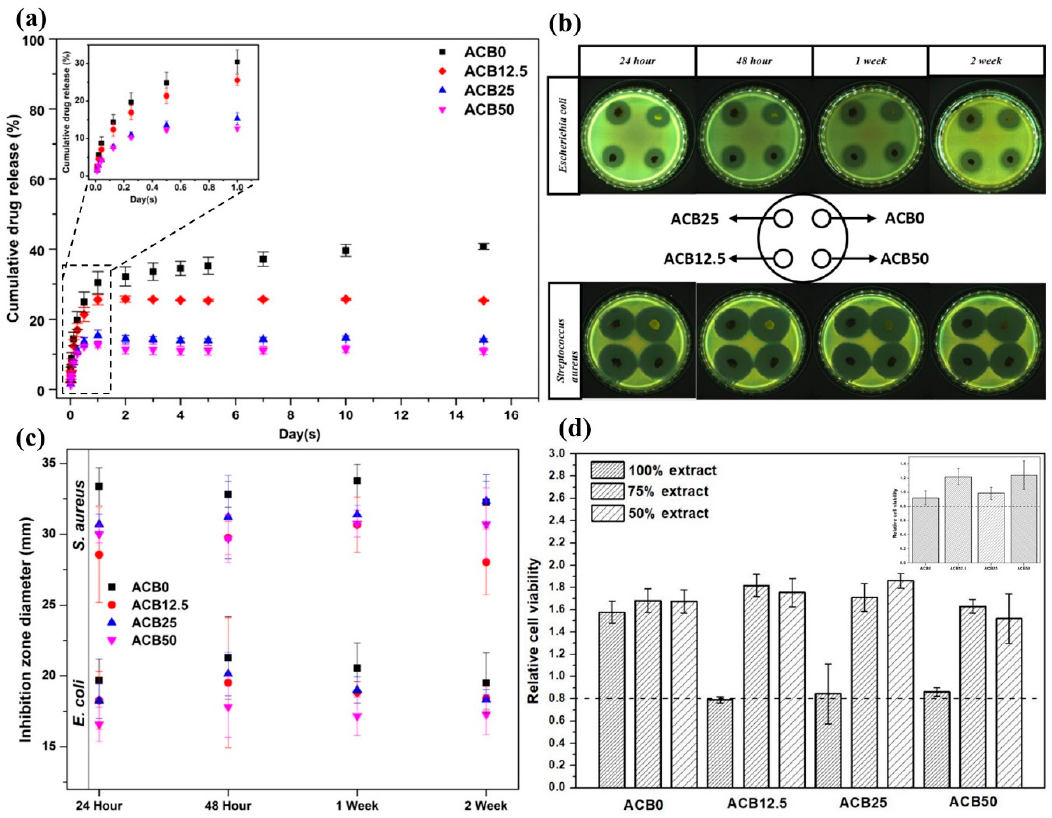
Figure 8. ( a ) Cumulative drug release, ( b ) antibacterial activity of ACB hydrogels, ( c ) inhibition zone diameters at 24 h, 48 h, 1 week and 2 weeks and ( d ) cytotoxicity of ACB hydrogels.